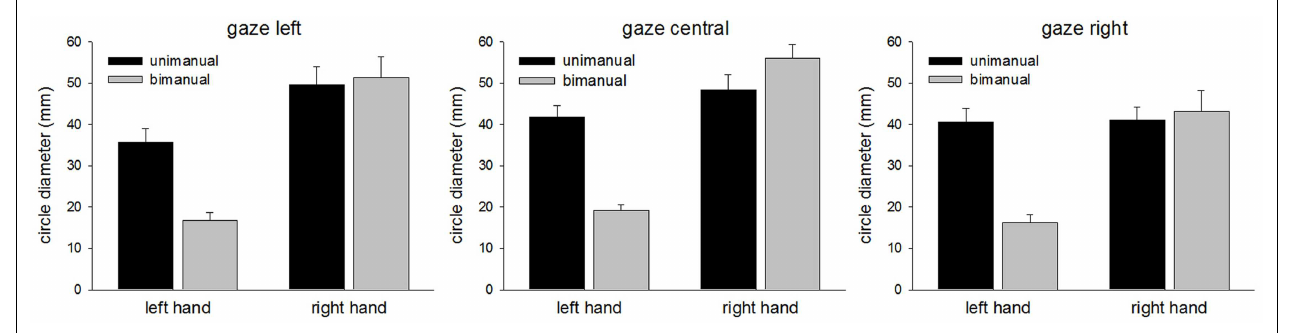
FIGURE 2 | Circle diameters for each condition in Experiment 1